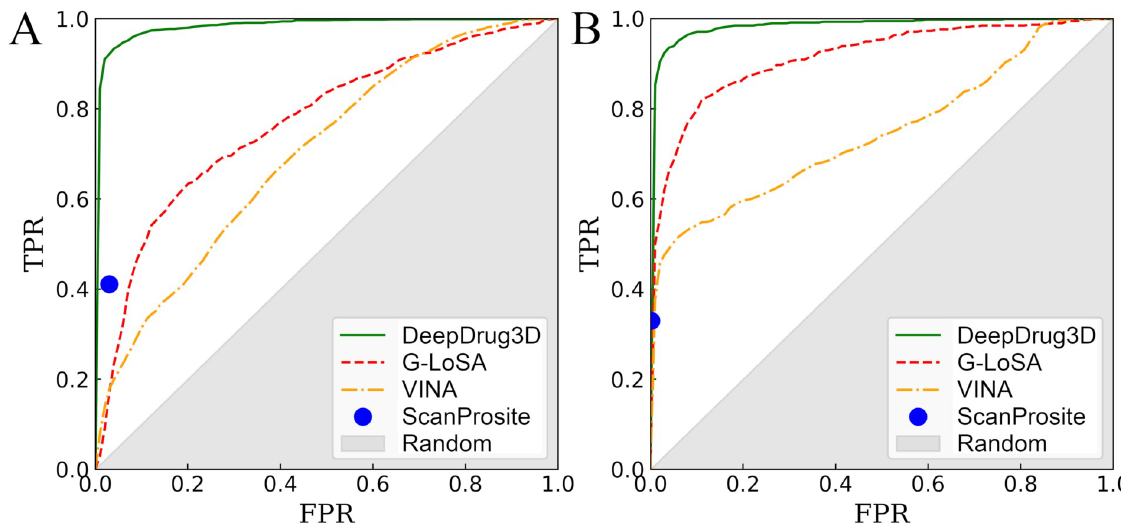
Fig 5. ROC plots evaluating the performance of DeepDrug3D and other methods to classify ligand-binding sites. DeepDrug3D is compared to pocket matching with G-LoSA, molecular docking with Vina, and sequence signature detection with ScanProsite for ( A ) nucleotide- and ( B ) heme-binding pockets. The x -axis shows the false positive rate (FPR) and the y -axis shows the true positive rate (TPR). The gray area represents a random prediction.